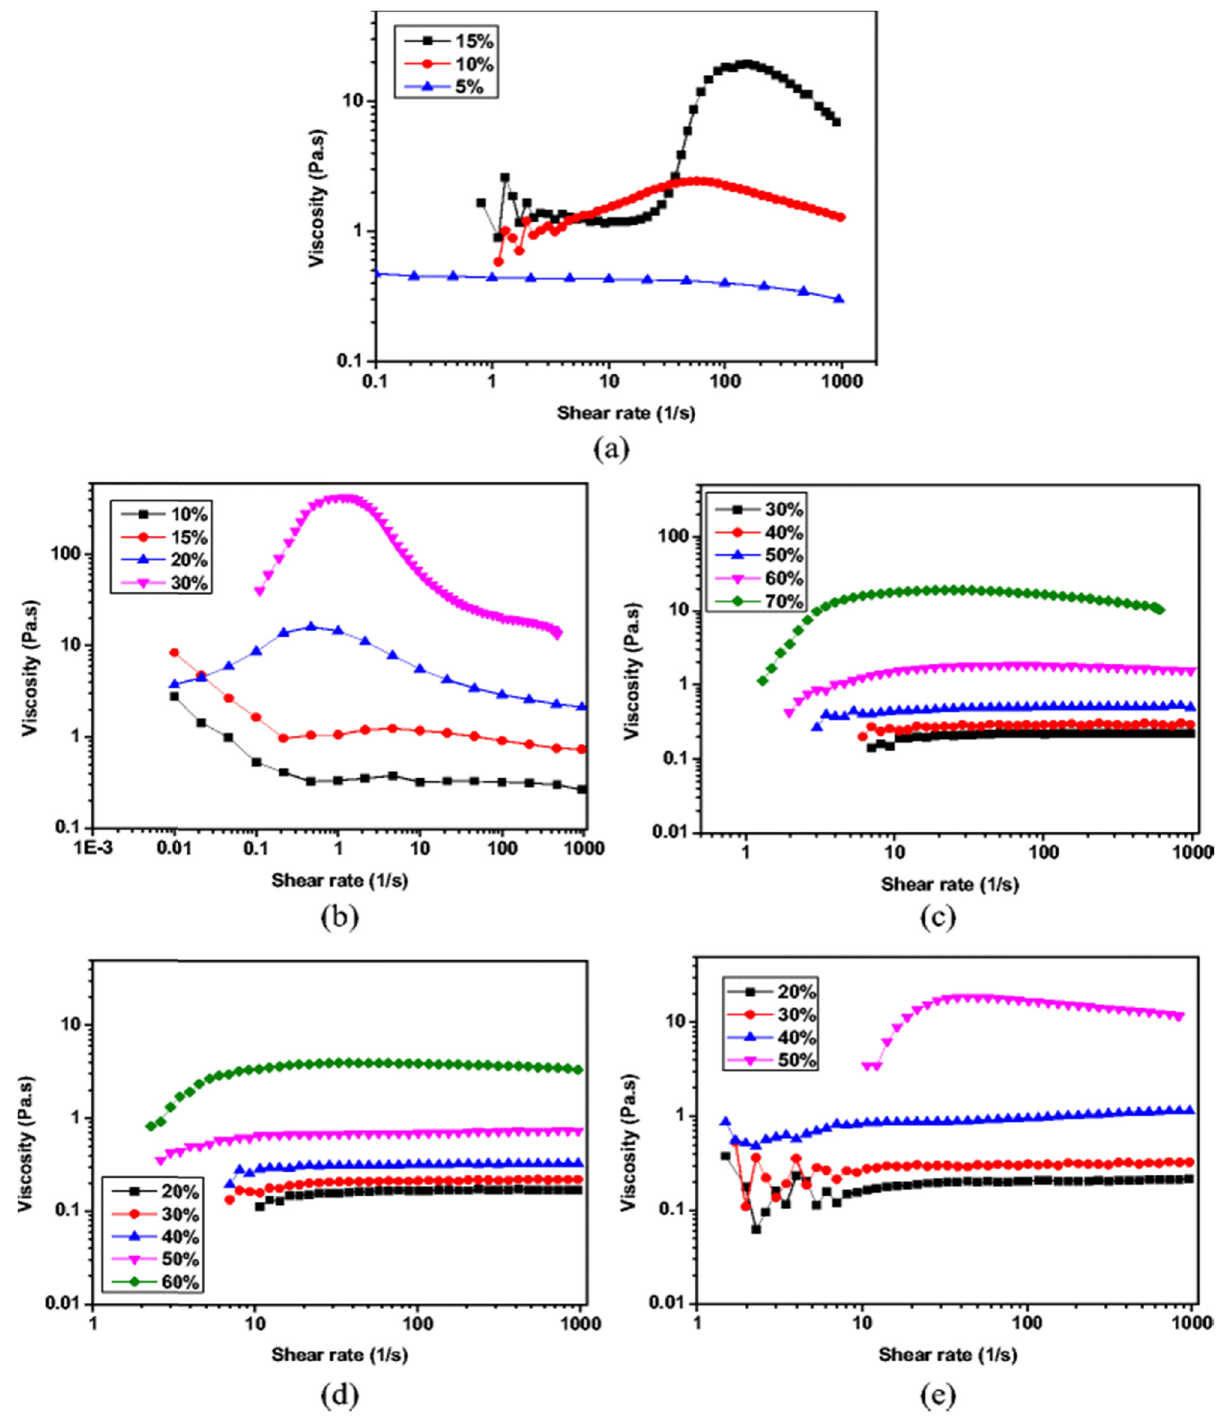
Figure 18: Plots of viscosity versus shear rate for the SiO 2 fl uids with di ff erent particle sizes and concentrations: ( a ) 15 nm, ( b ) 30 nm,